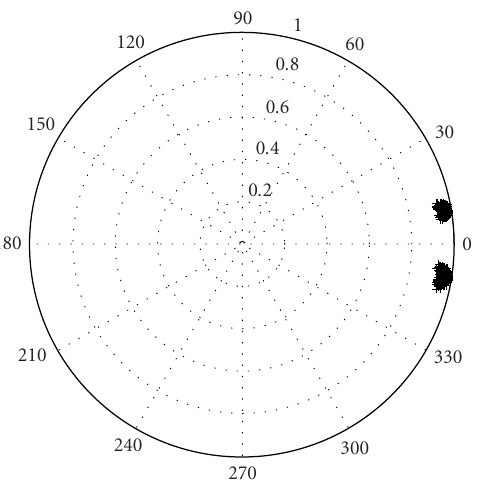
Figure 2: Selected polynomial roots by the proposed method.